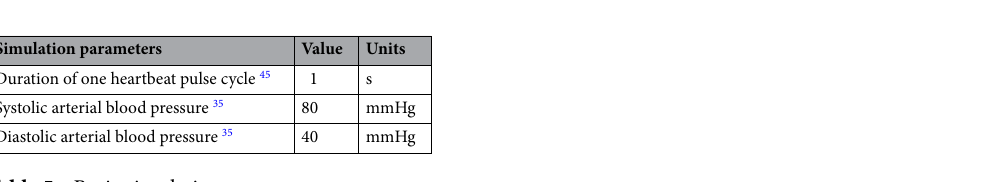
Table 5. Basic simulation parameters.